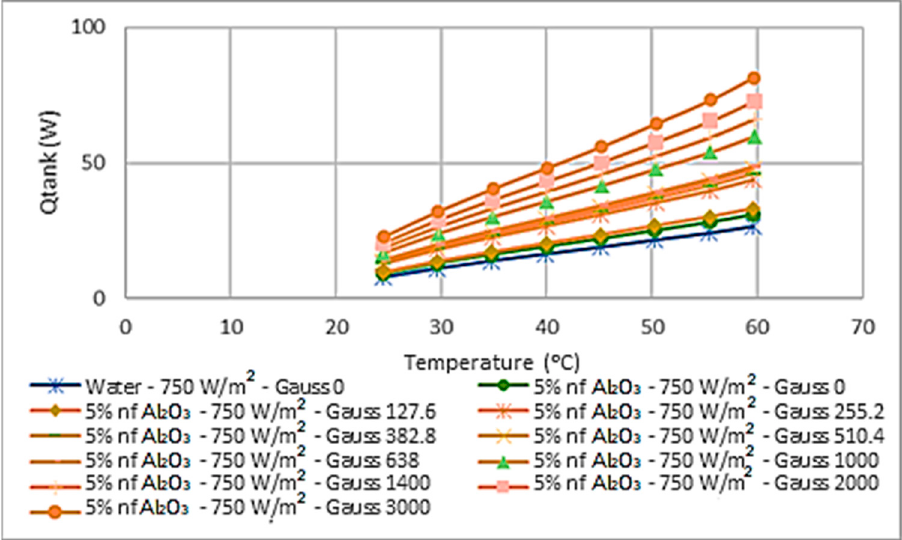
Figure 13. Thermal energy generated in thermal tank by PV-Th solar panels.